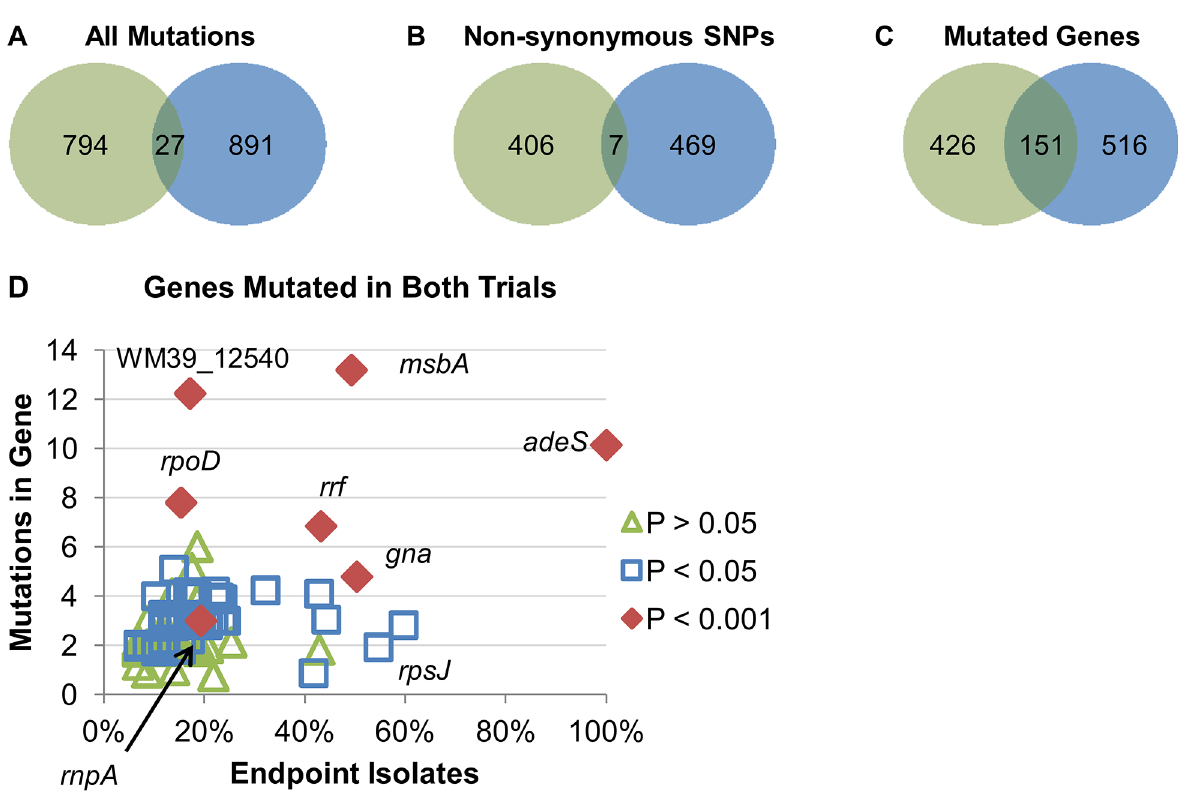
Fig 5. Parallel evolution suggests genes that may contribute to TGC resistance. Venn diagrams represent (A) the number of mutations, (B) nsSNPs, or (C) genes that were observed in the individual trials or combined (Trial 1, green; Trial 2 blue). (D) Genes mutated in both trials were plotted based on the number of mutations in the gene and the percentage of clones that contained at least one mutation in the gene. False noise was added to the number of mutations in each gene to separate the spots. P values were calculated using Fisher ’ s Exact Test. Genes with p values < 0.001 are labeled. Due to its role in TGC resistance, rpsJ was also